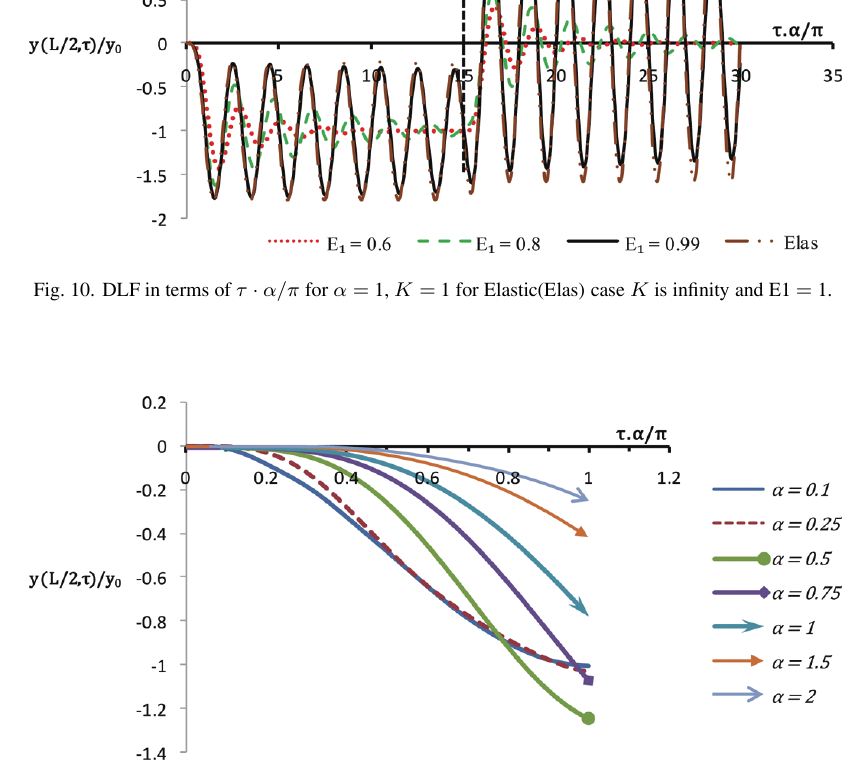
Fig. 11. DLF in terms of τ · α/π for different values of α at arrival and E 1 = 0.75, K =